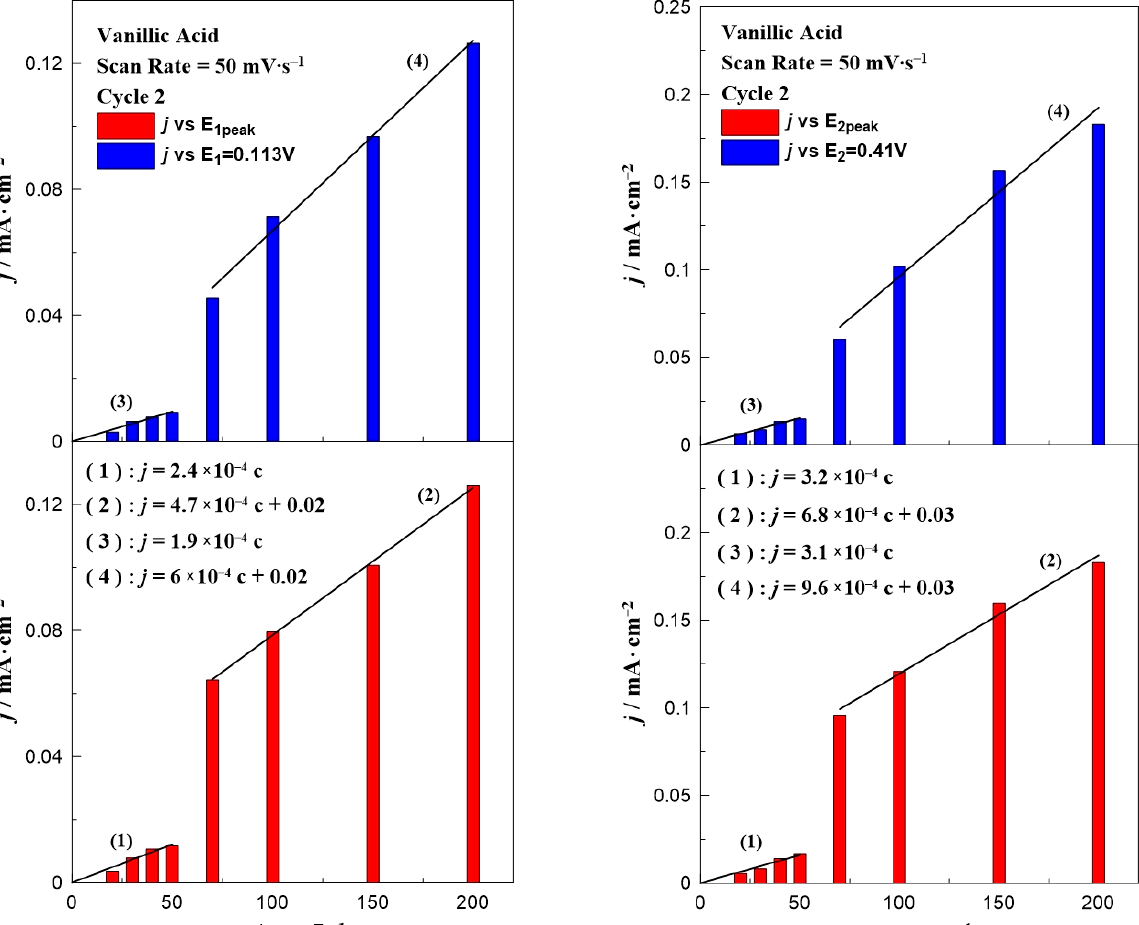
Figure 6. The effect of vanillic acid concentration on the current density value at E 1 and E 1, peak ( left ) and E 2 and E 2, peak ( right ) at a constant scan rate of 50 mV · s − 1 .